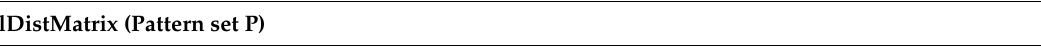
Algorithm 2. CalDistMatrix Algorithm. CalDistMatrix (Pattern set